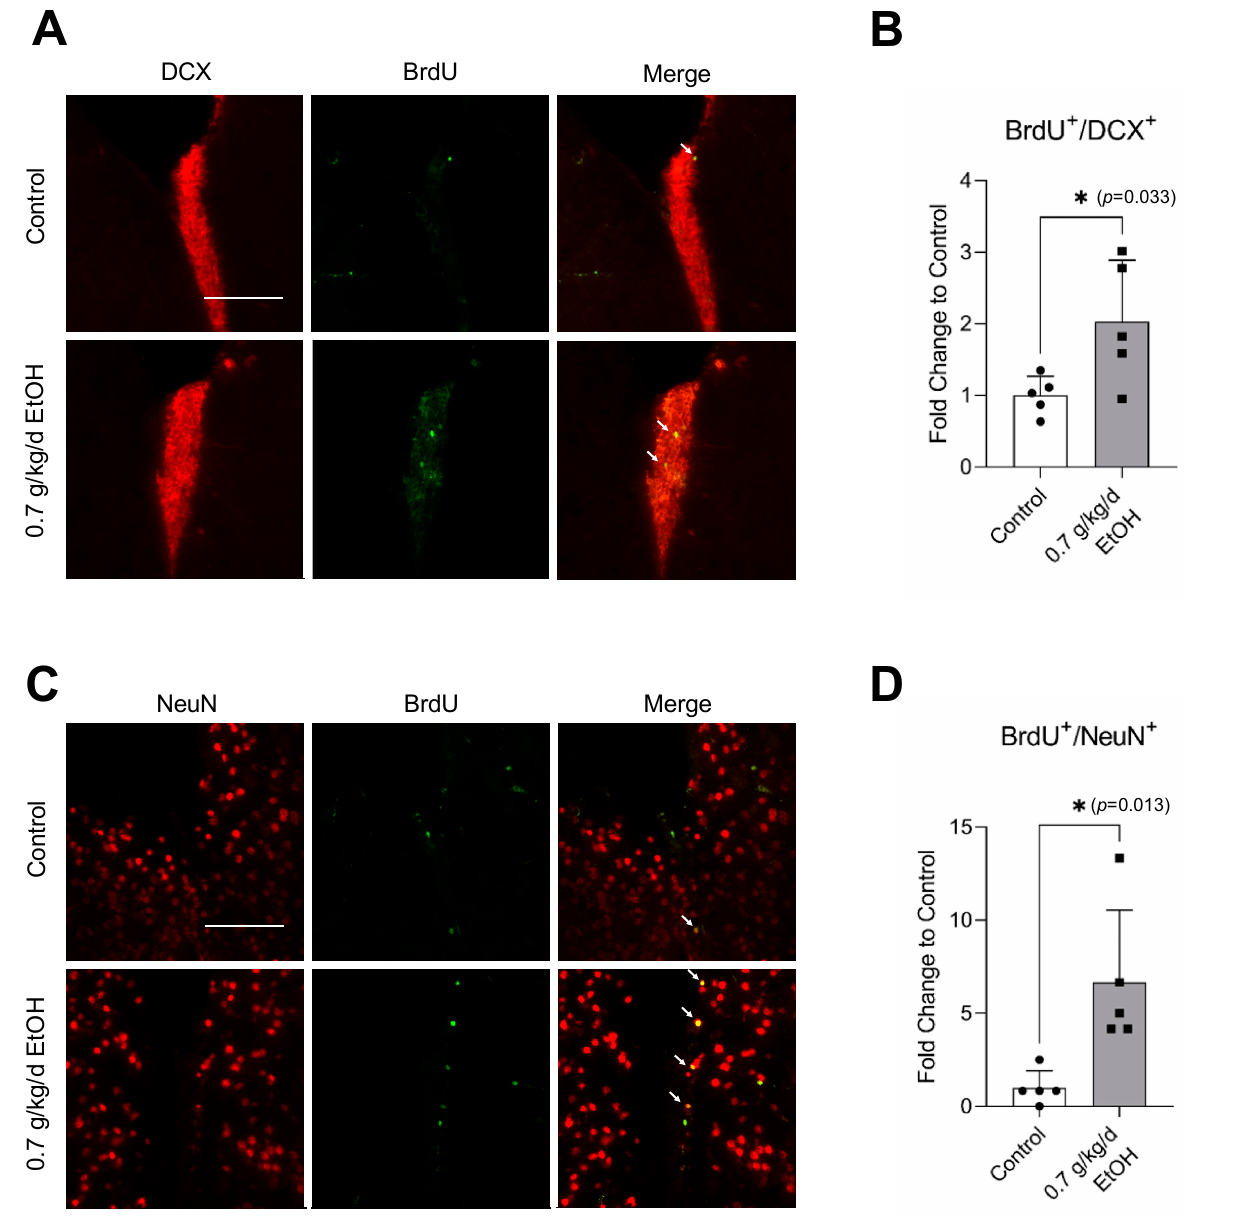
Figure 1. Effect of LAC on baseline neurogenesis in the SVZ. ( A ) Representative double staining of BrdU and DCX. Scale bar = 100 µm. ( B ) Values are means ± SD ( n = 5). ( C ) Representative double staining of BrdU and NeuN. ( D ) Values are means ± SD ( n = 5); * p < 0.05 vs. Control. Analyzed using an unpaired t